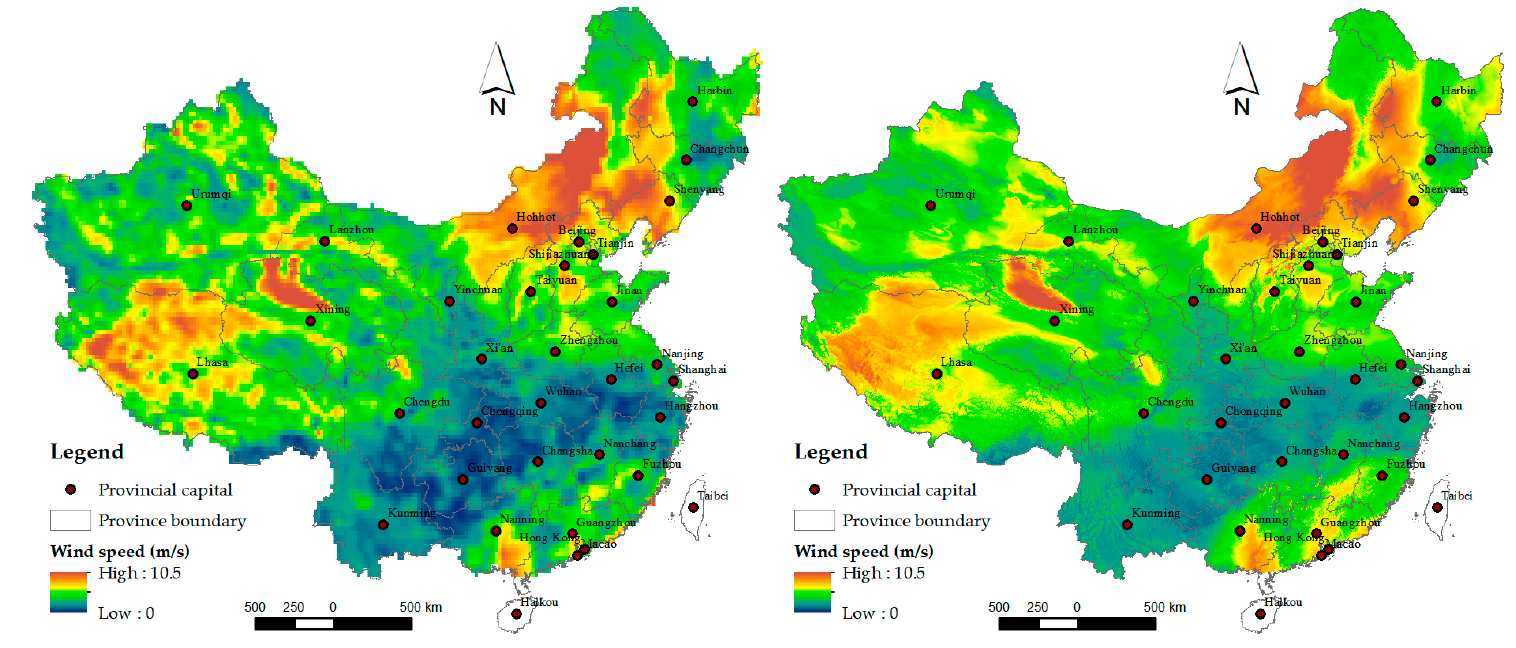
Figure 12. Adjusted wind speed image at a height of 10–12 m above the ground ( b , d ) by downscaling of deep residual network and their original coarsely resolved image ( a , c ) for 1 January 2015 ( a , b ) in winter and 1 July 2015 ( c , d ) in summer.